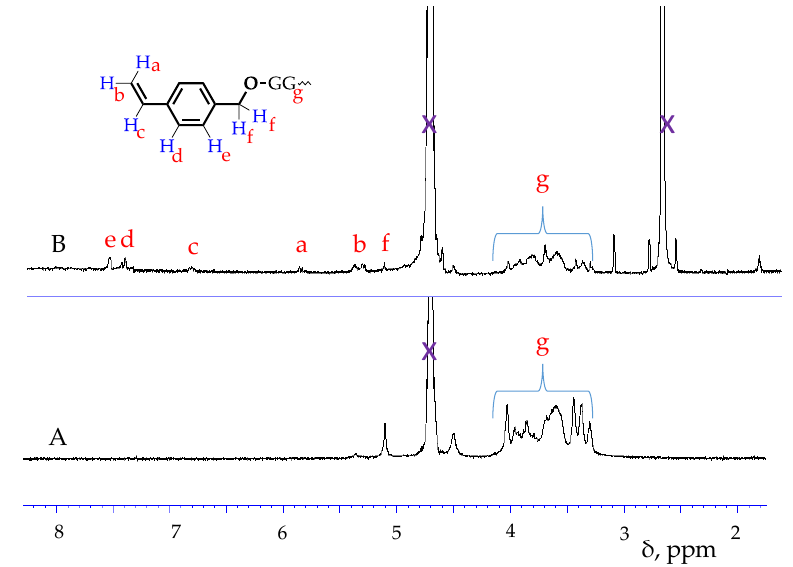
Figure 4. NMR spectra of GG (A) and VBzGG-3 (B) in D 2 O. X—solvent peaks.